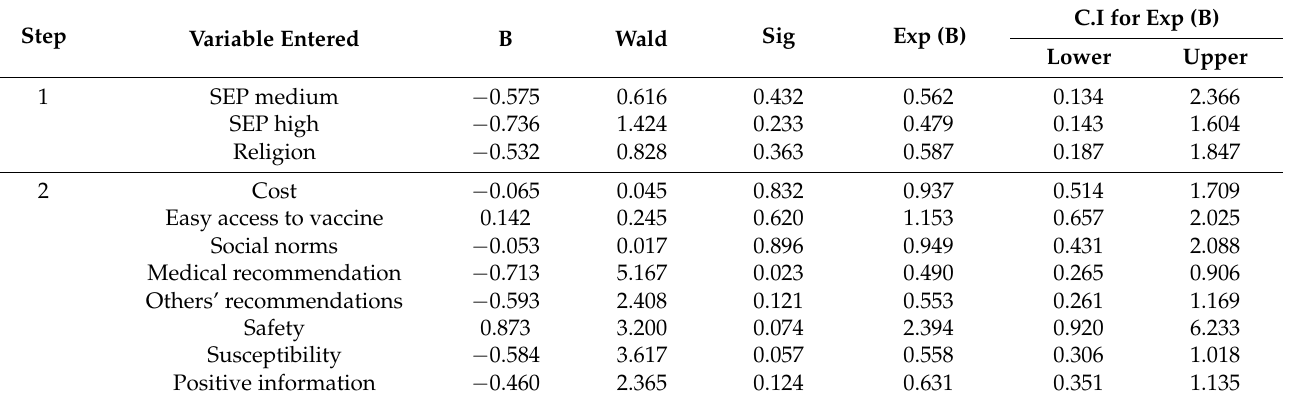
Table 4. Logistic regression results for predicting the reasons to vaccinate daughters using socioeco- nomic position (SEP), religion, and other influences as independent